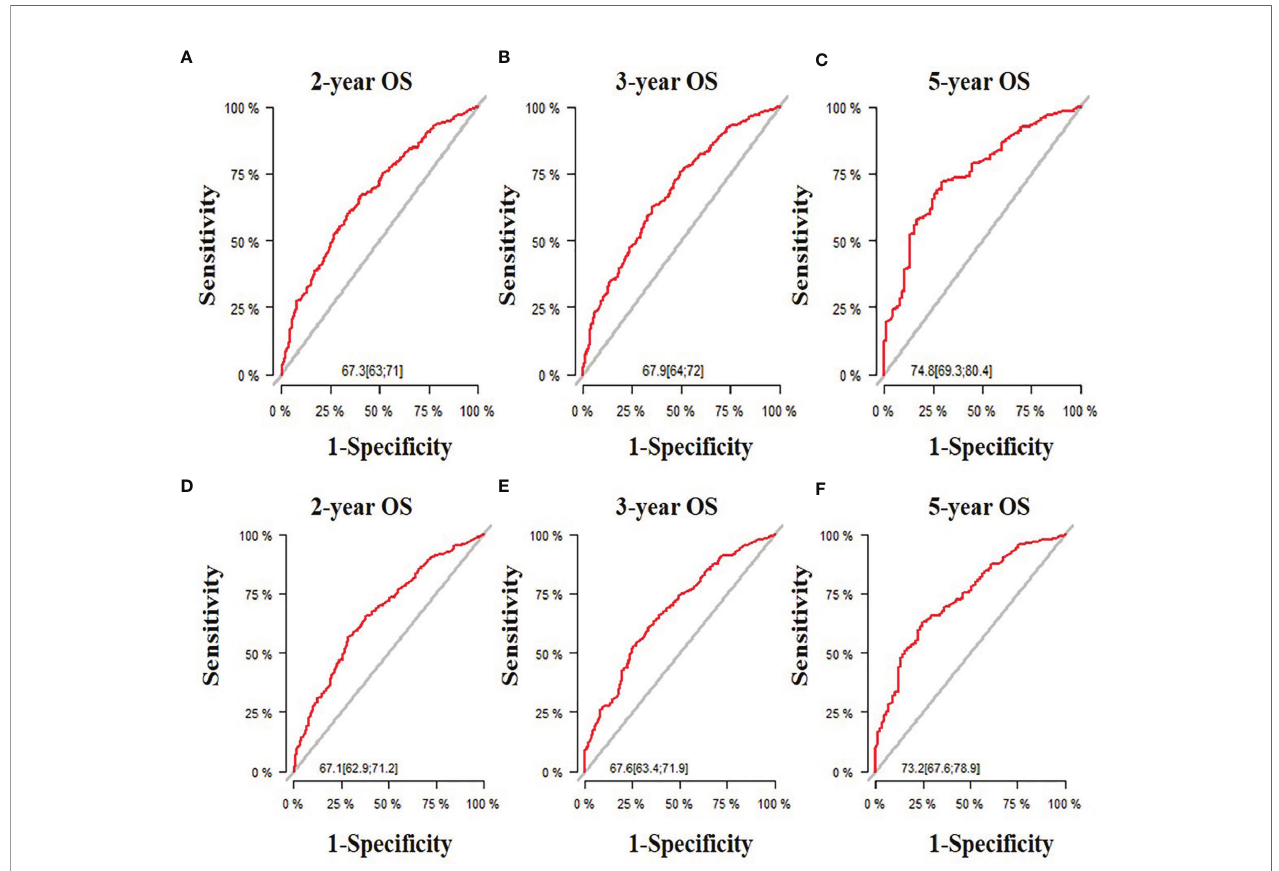
FIGURE 2 | The receiver operating characteristic (ROC) curve and area under the ROC curve. (A) Predicting 2-year OS in the training cohort; (B) Predicting 3-year OS in the training cohort; (C) Predicting 5-year OS in the training cohort; (D) Predicting 2-year OS in the validation cohort; (E) Predicting 3-year OS in the validation cohort; (F) Predicting 5-year OS in the validation